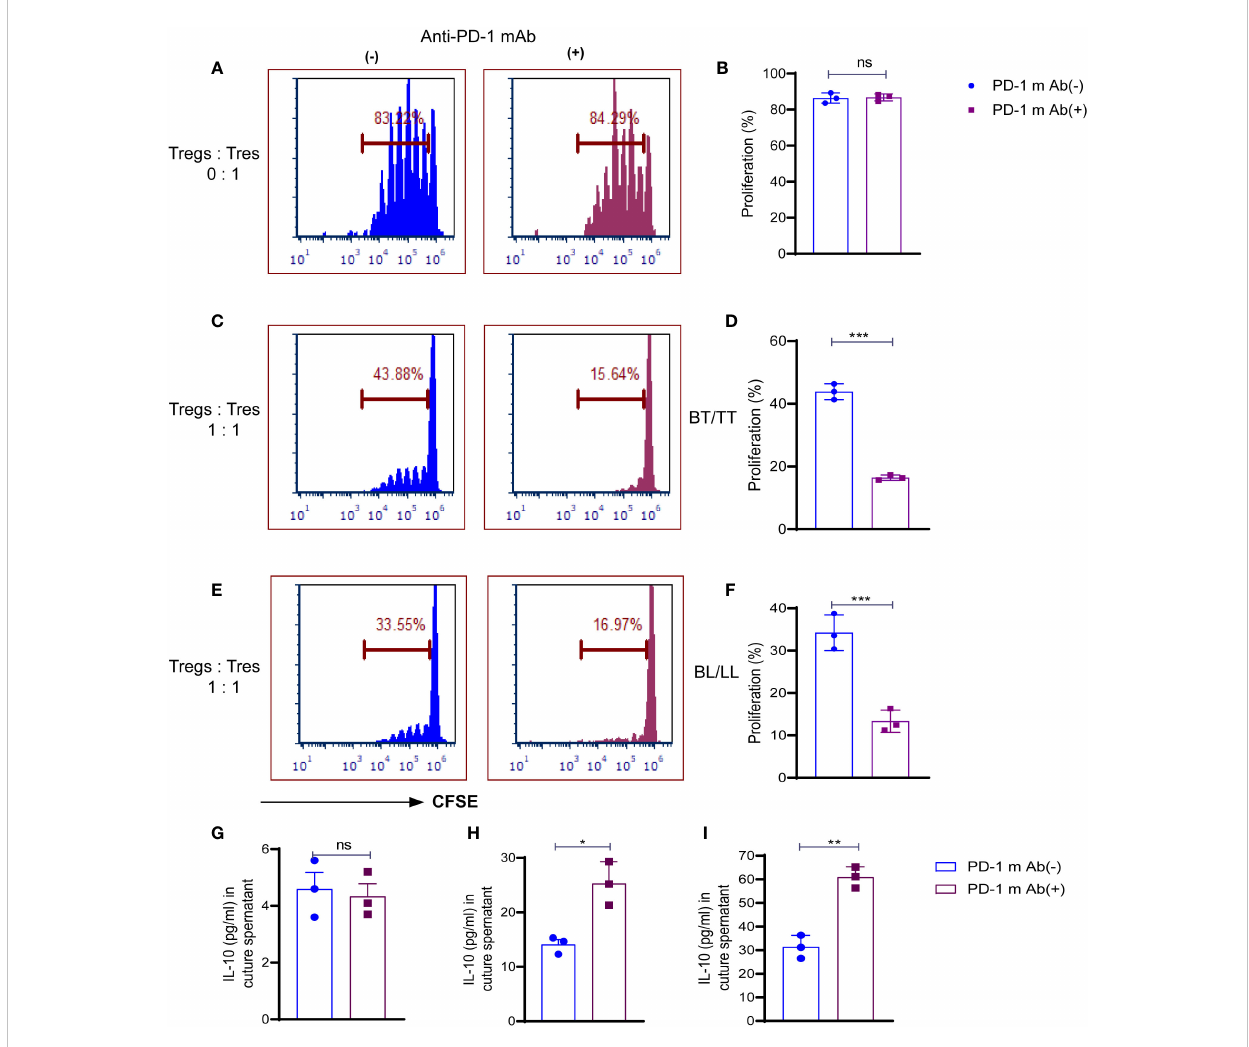
FIGURE 3 Role of PD-1 in Treg cell-mediated immunosuppression in leprosy. CSFE labelled CD8+T cells (Tresp cells) from PBMCs of healthy control cultured with irradiated APCs cultured and ant-CD3 with and without anti-mAb of PD-1. (A) Histogram showing percent of proliferating Tresp cells in the cultures with and without anti-mAb of PD-1 (15 µg/ml) with PD-1+Treg sorted cells from healthy controls (n=3) (B) Scattered dot plots showing proliferation of CD8+T cells (Tresp cells) without co-culture of Tregs, and CFSE-labeled CD8+T cells (Tresp cells) were cultured for 5 days with anti- CD3 mAb and irradiated APCs. Proliferation of Tresp cells was determined by CFSE dilution with and without PD-1 blocking (15 µg/ml). (C) Histogram (D) Scattered dot plots showing proliferation of CD8+T cells (Tresp cells) when PD-1+Treg sorted cells from BT/TT patients (n=3), and CFSE-labeled CD8+T cells (Tresp cells) were cocultured for 5 days with anti-CD3 mAb and irradiated APCs. Proliferation of Tresp cells was determined by CFSE dilution with and without PD-1 blocking (15 µg/ml). (E) Histogram (F) Scattered dot plots showing proliferation of CD8+T cells (Tresp cells) when PD-1+Treg sorted cells from BL/LL patients (n=3), and CFSE-labeled CD8+T cells (Tresp cells) were cocultured for 5 days with anti-CD3 mAb and irradiated APCs. Proliferation of Tresp cells was determined by CFSE dilution with and without PD-1 blocking (15 µg/ml). (G)